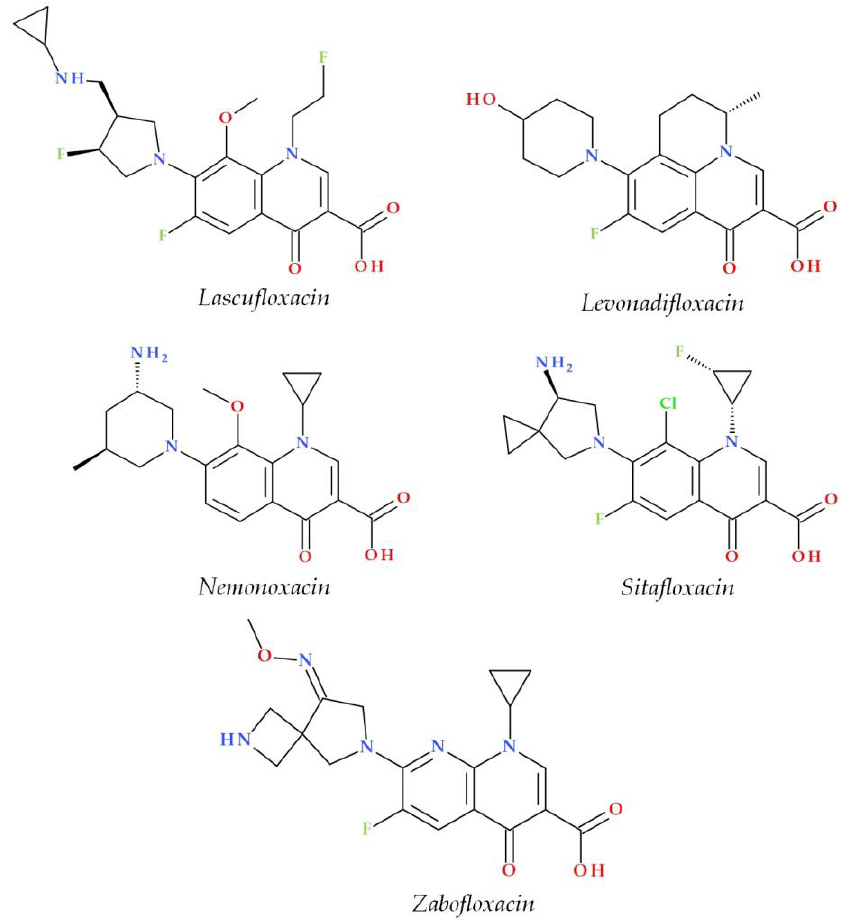
Figure 3. Chemical structures of the recently approved systemic antibacterial (fluoro)quinolones in the countries where they were produced.